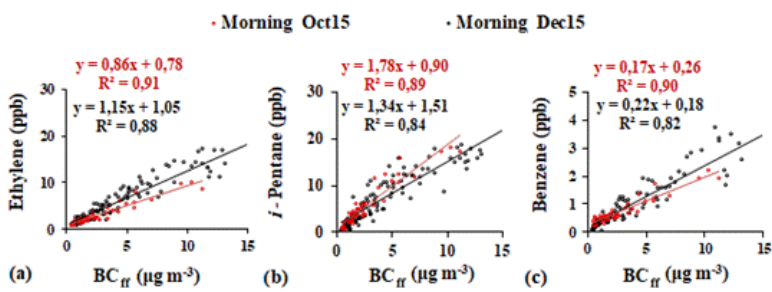
Figure 10. Regressions between ethylene, i- pentane and benzene versus BC ff (a) – (c) for the morning periods (07:00–10:00LT) in October and December 2015.